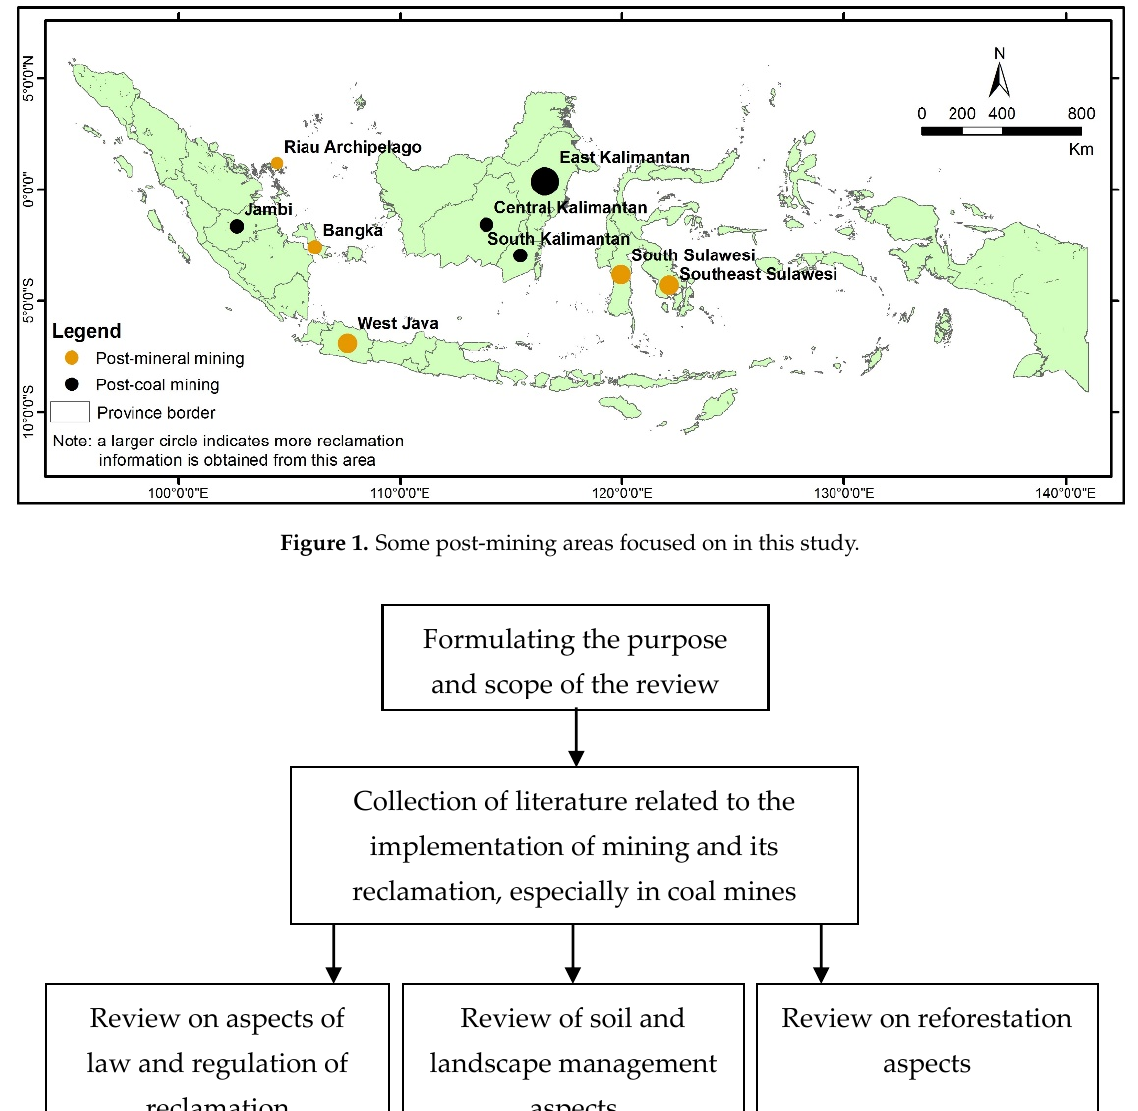
Figure 1. Some post-mining areas focused on in this study.